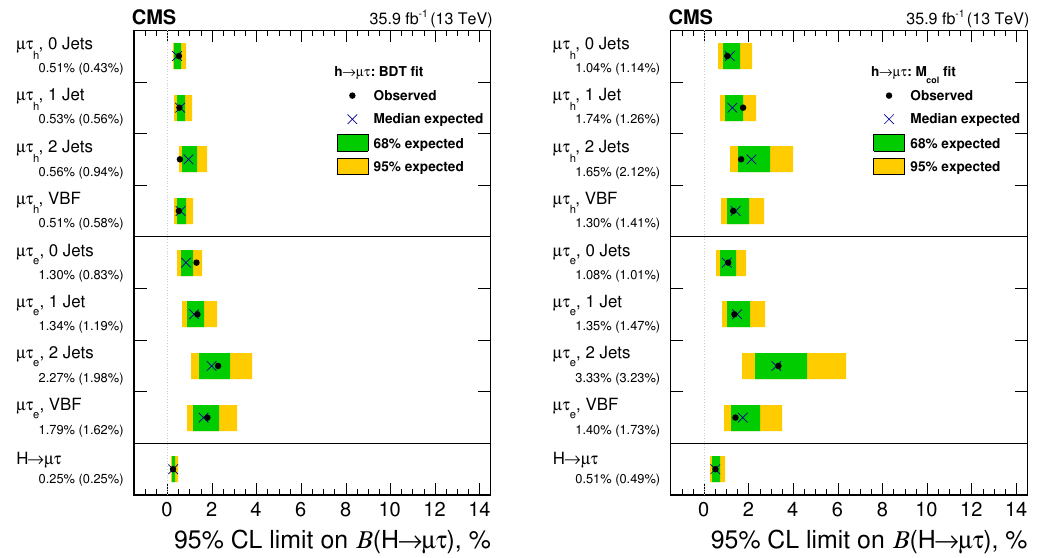
Figure 6 . Observed and expected 95% CL upper limits on the B (H ! (cid:22)(cid:28) ) for each individual category and combined. Left: BDT (cid:12)t analysis. Right: M col (cid:12)t analysis.